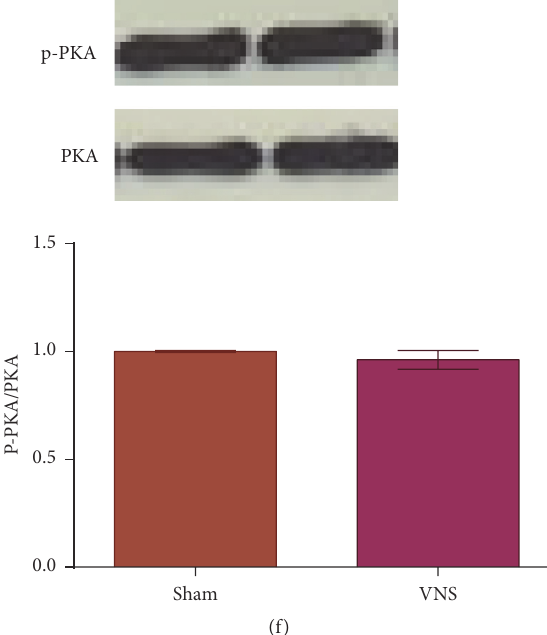
Figure 1: Increased expression of p-CaMKII and decreased expression of Arc protein in the BLA of animals given VNS during extinction training. (a) Timeline of behavioral protocol. On days 1 and 2 rats were subjected to auditory fear conditioning (AFC) followed by a conditioned fear response test (CFRT) on day 3. On day 4 rats underwent extinction training (EXT) and were sacrificed 45min later. (b) Rats given VNS during extinction training show higher levels of p-CaMKII compared to rats given sham stimulation ( ∗ 𝑝 < 0.05 ). (c, d) No significancedifference in expression of CaMKII 𝛼 or CaMKII 𝛽 across groups. (e) VNS-treatedratsshow lower levelsof Arcproteinexpression compared to sham-treated rats ( ∗ 𝑝 < 0.05 ). (f) No difference in p-PKA expression across groups.